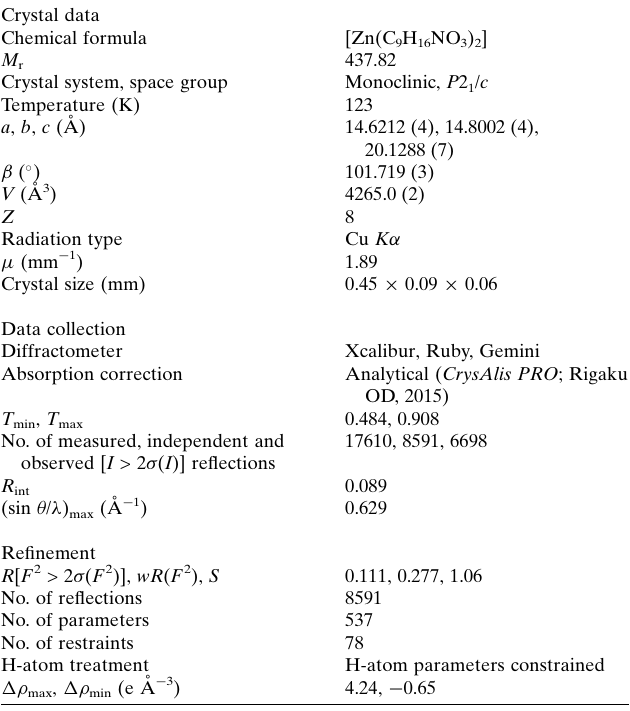
Table 3 Experimental details. Crystal data Chemical